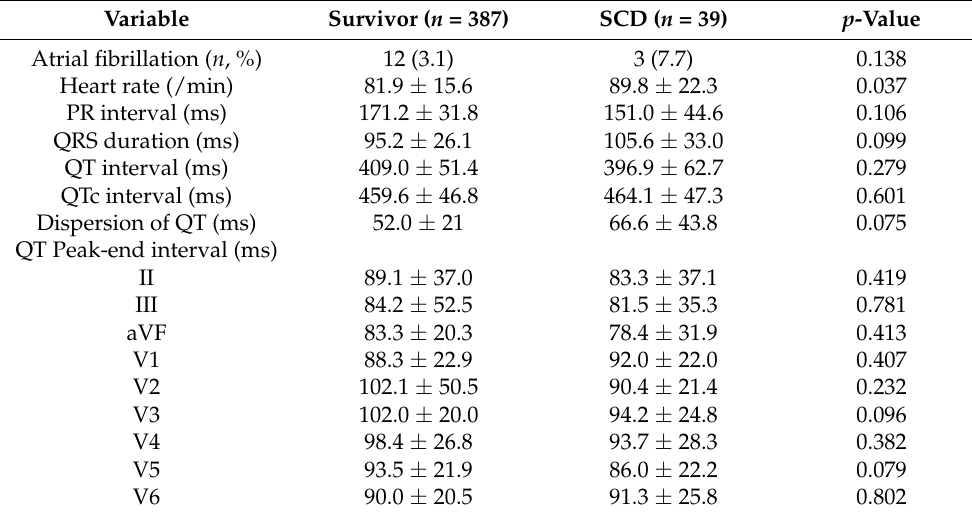
Table 3. Baseline ECG findings after